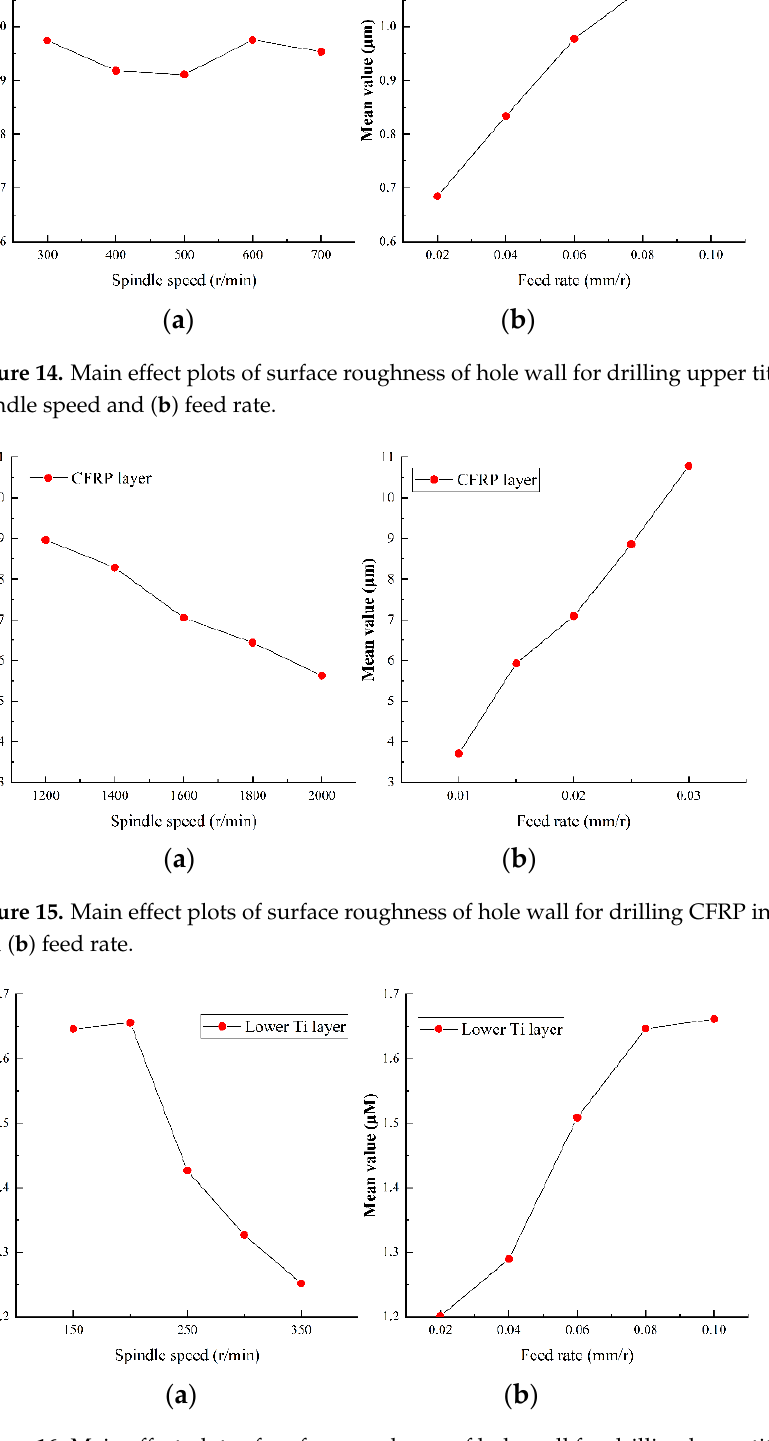
Figure 16. Main effect plots of surface roughness of hole wall for drilling lower titanium alloy in ( a ) spindle speed and ( b ) feed rate.